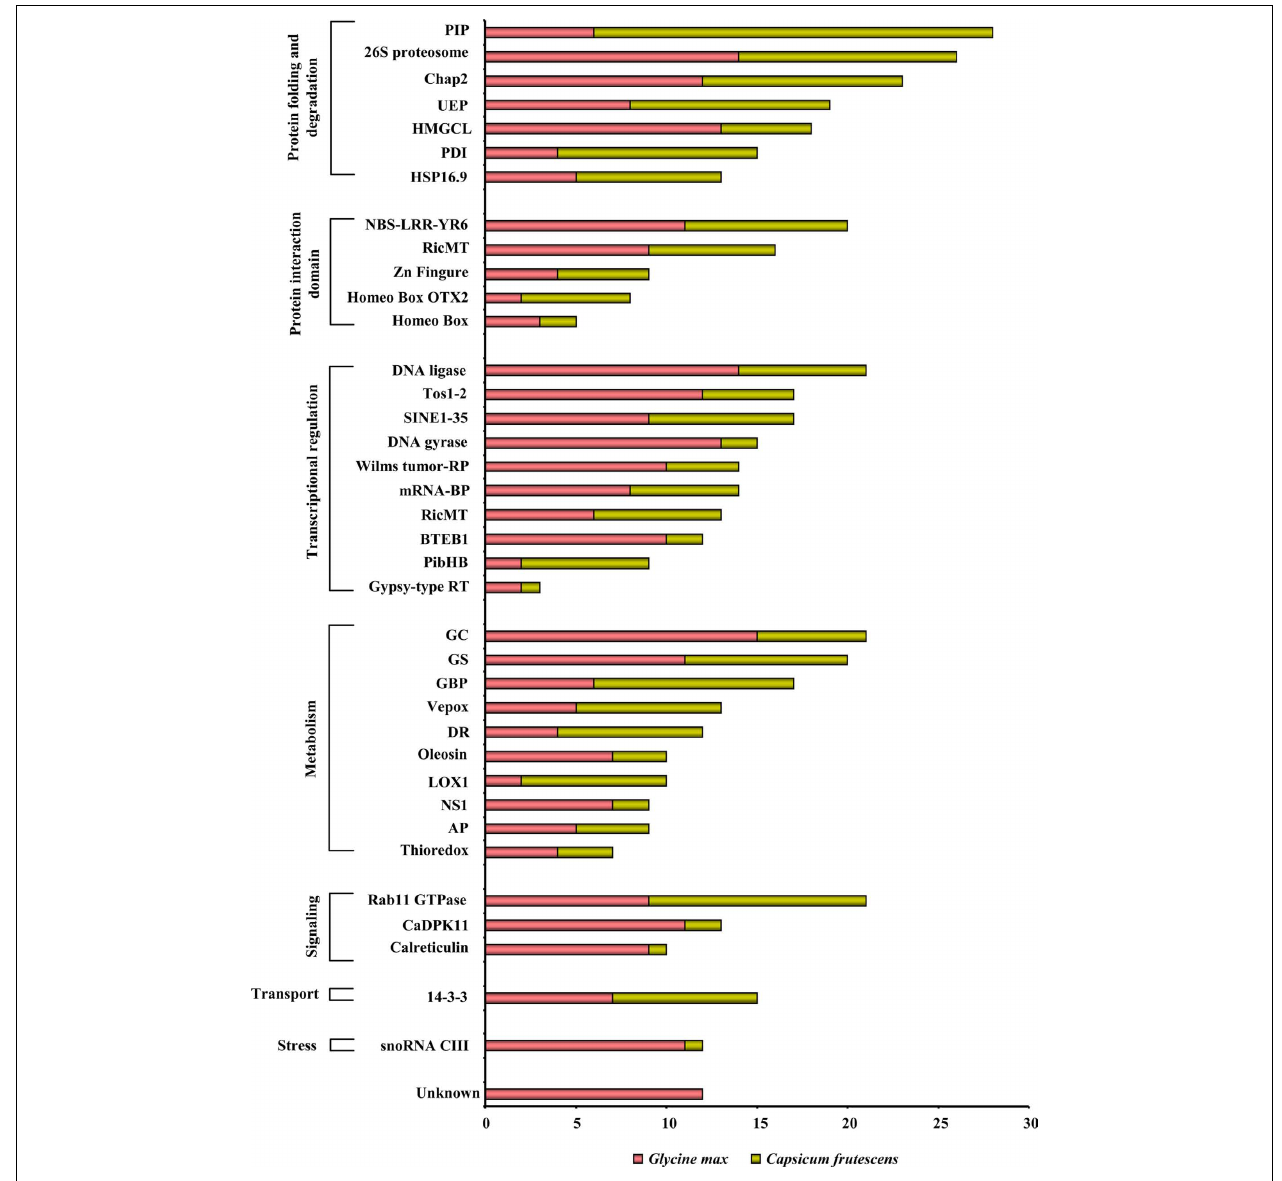
FIGURE 4 | Comparative patho-stress responsive nuclear proteome:The functional classification of the identified proteins was according to the biological processes in which they are involved. The length of the bars indicates the number of proteins present in a particular stress.